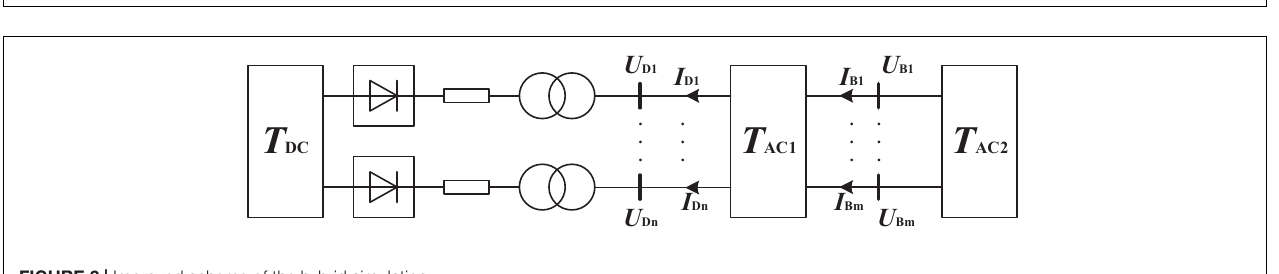
FIGURE 2 | Improved scheme of the hybrid simulation.